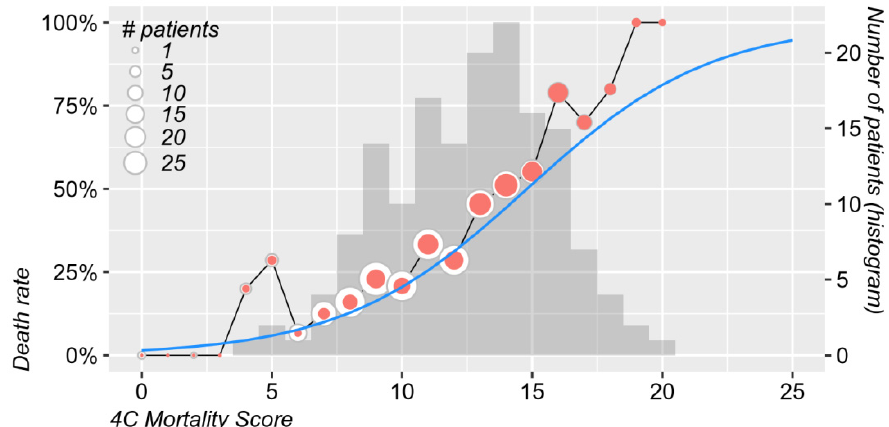
Figure 3. Death rate (left y axis) and distribution (right y axis) of the original 4CM Scores. Dot sizes are proportional to the number of patients with each score value, with the inner red dots showing the fatal cases. The smooth blue line shows the predicted death rate according to the logistic model (GLM).